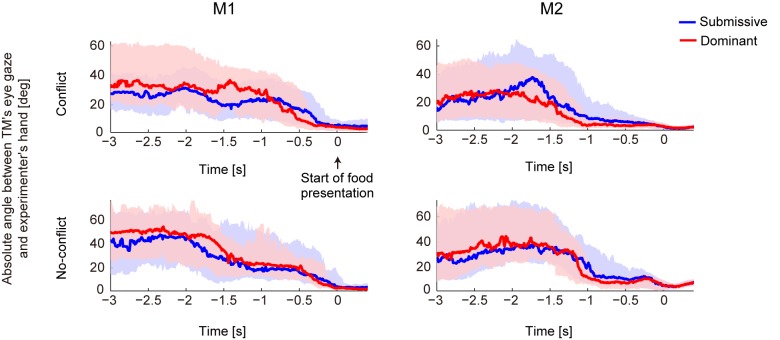
Temporal changes in eye gaze of the TM.The absolute values of the horizontal visual angle between the TM’s eye gaze and the top of the experimenter’s right hand were calculated for the conflict and no-conflict conditions for monkeys M1 and M2. In the conflict condition, the trials for the right and left conflict spaces were combined into one condition. The experimenter put his right hand under the table during the waiting and food-preparation periods, and the experimenter’s hand appeared above the table and the food was held in the right hand during the food-presentation period. The smaller angle around the start of the food-presentation period means that the TM always looked at the food. The blue and red lines represent the median angle for the submissive and dominant conditions, respectively. The lower and upper values of the shaded areas around the plots show the first and third quartiles of the angles, respectively.